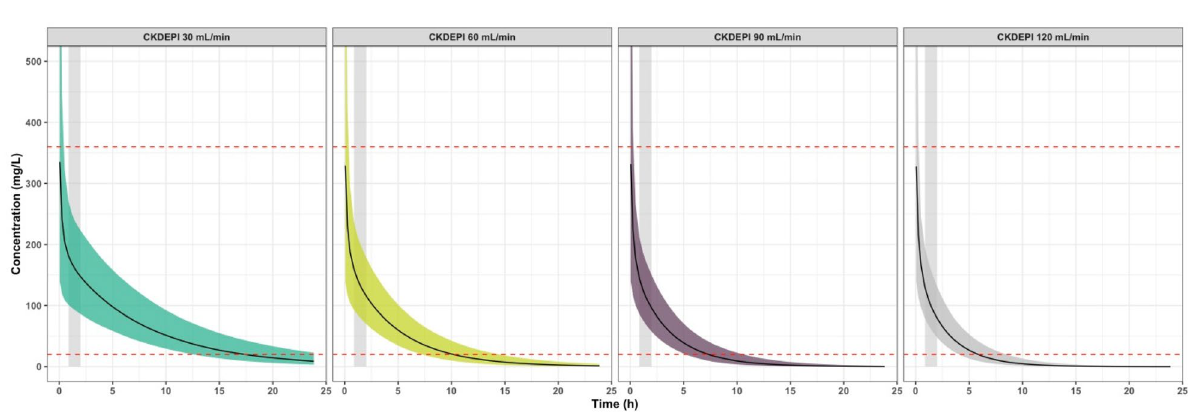
Figure 4. Simulations of the concentration–time course of cefazolin after a 2000 mg bolus. The simulations illustrate the effect of CrCL on cefazolin exposure over time in a patient with a CrCL of 30 mL/min/1.73 m 2 (left panel), 60 mL/min/1.73 m 2 (middle left panel), 90 mL/min/1.73 m 2 (middle right panel) or 120 mL/min/1.73 m 2 (right panel). The red dashed lines correspond to the 20 and 360 mg/litre concentration thresholds. Black solid lines correspond to the mean cefazolin concentrations. Coloured shaded areas correspond to the interpatient variability intervals estimated in our model. The grey stripe represents the surgery duration. Simulations were performed using R software (version 3.2.2) with the ggplot2 package (version 2.1.0). R Core Team (2016). R: A language and environment for statistical computing. R Foundation for Statistical Computing, Vienna, Austria. URL https:// www.R- proje ct. org/. Wickham H (2016). ggplot2: Elegant Graphics for Data Analysis . Springer- Verlag New York. ISBN 978–3-319–24,277-4, https:// ggplo t2. tidyv erse.